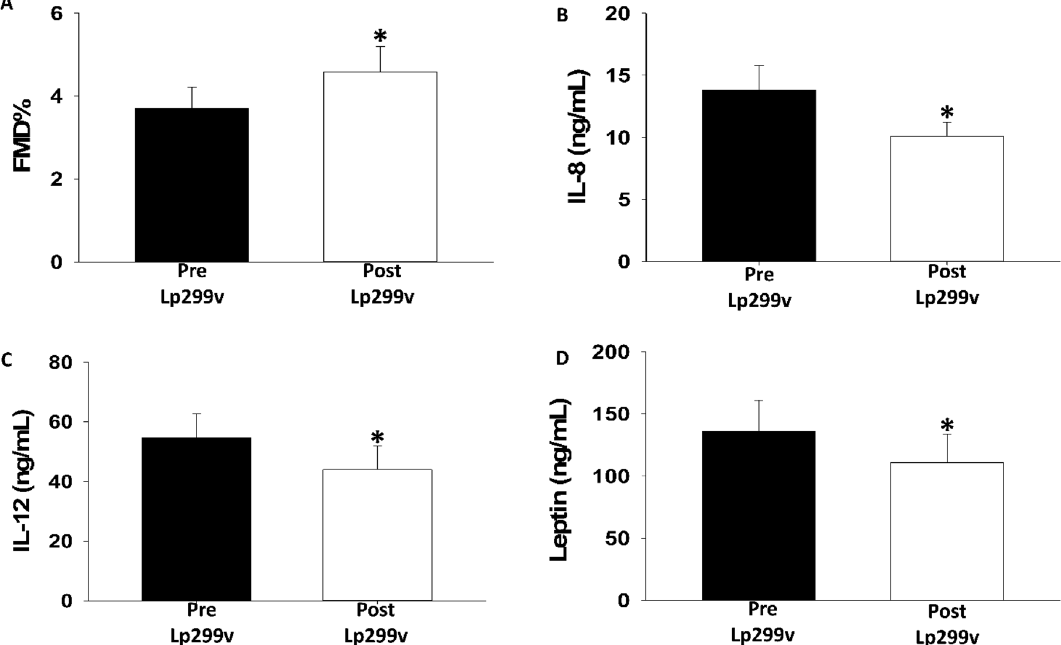
Figure 1. Effects of Lp299v supplementation on Brachial Artery FMD, ILs-8, 12, and Leptin in Non-Daily Alcohol Drinkers: Lp299v supplementation resulted in ( A ) improved brachial flow mediated dilation (FMD)% (3.70 ± 0.51 vs. 4.58 ± 0.61%, n = 15; P = 0.016) while IL-8 ( B, 13.8 ± 2.0 vs. 10.1 ± 1.1 pg/mL, n = 15; P = 0.032), IL-12 ( C, 54.6 ± 8.1 vs. 33.0 ± 7.9 pg/mL, n = 15; P = 0.042), and leptin ( D , 136 ± 25 vs. 111 ± 23 ng/mL, n = 15; P = 0.002) all significantly decreased. All statistical tests paired t-tests. All values given as mean ± SE. *p <